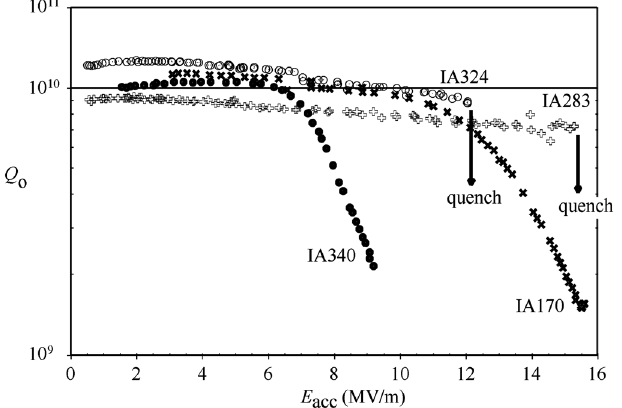
FIG. 3. Representative performance of CEBAF cavities in 2 K acceptance tests (from [51]).